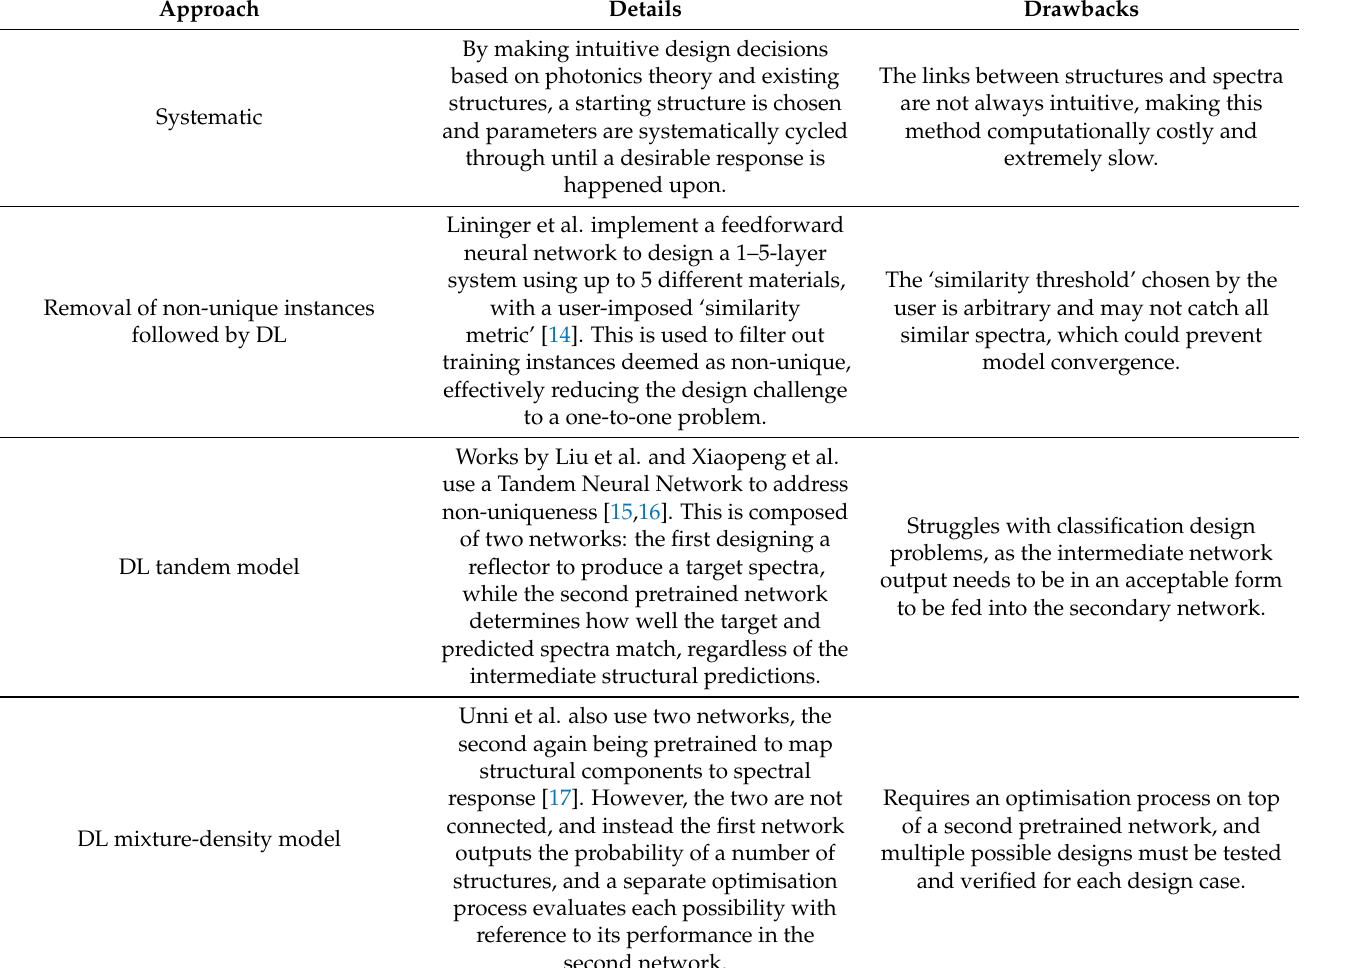
Table 1. A summary of existing methods of inverse design and their